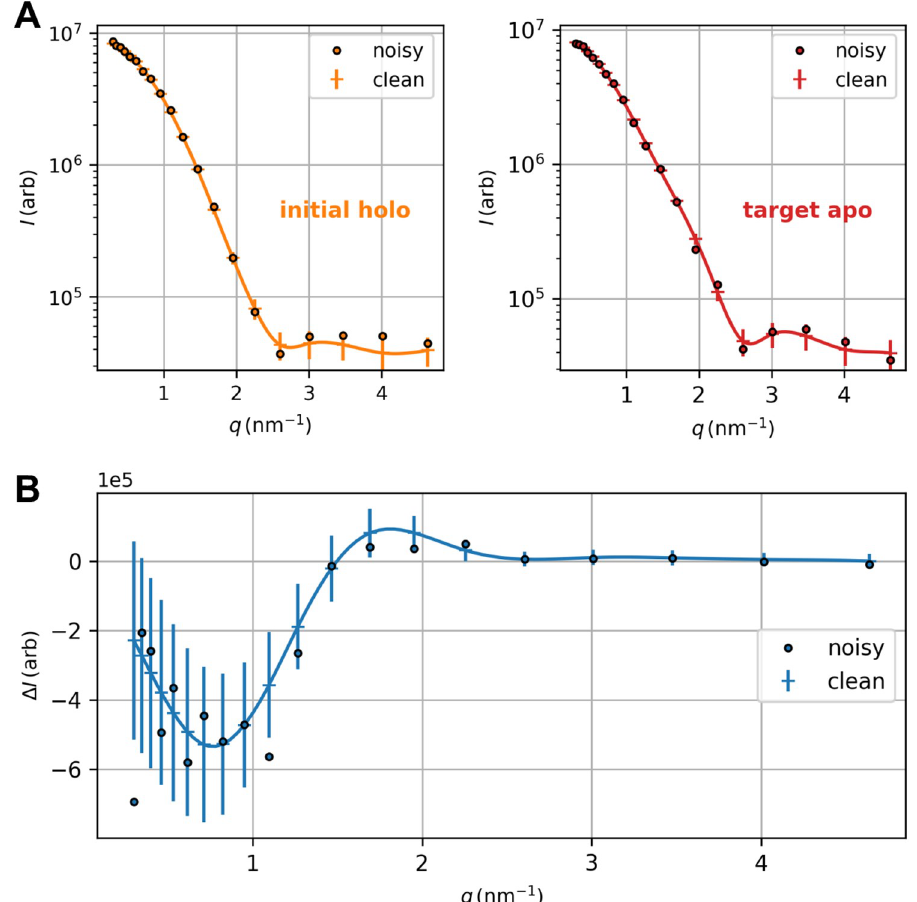
Fig 10. Noisy artificial difference data for LAO protein’s holo-to-apo transition. (A) Blurred absolute intensities of initial holo state (orange circles, left) and target apo state (red circles, right) along with related clean scattering curves (solid lines) and error bars. For each q point, a ‘blurred’ intensity value was randomly taken from a Gaussian distribution centered at the corresponding clean intensity. The standard deviation and intensity error was calculated as the square root of the clean intensity value. (B) Noisy difference scattering data (blue circles) were obtained by subtracting the blurred absolute initial intensity (orange circles above) from the blurred absolute target intensity (red circles above). Clean difference data are depicted as solid line with related error bars. Errors were derived via usual error propagation and used to individually weight the different q points in the simulation.